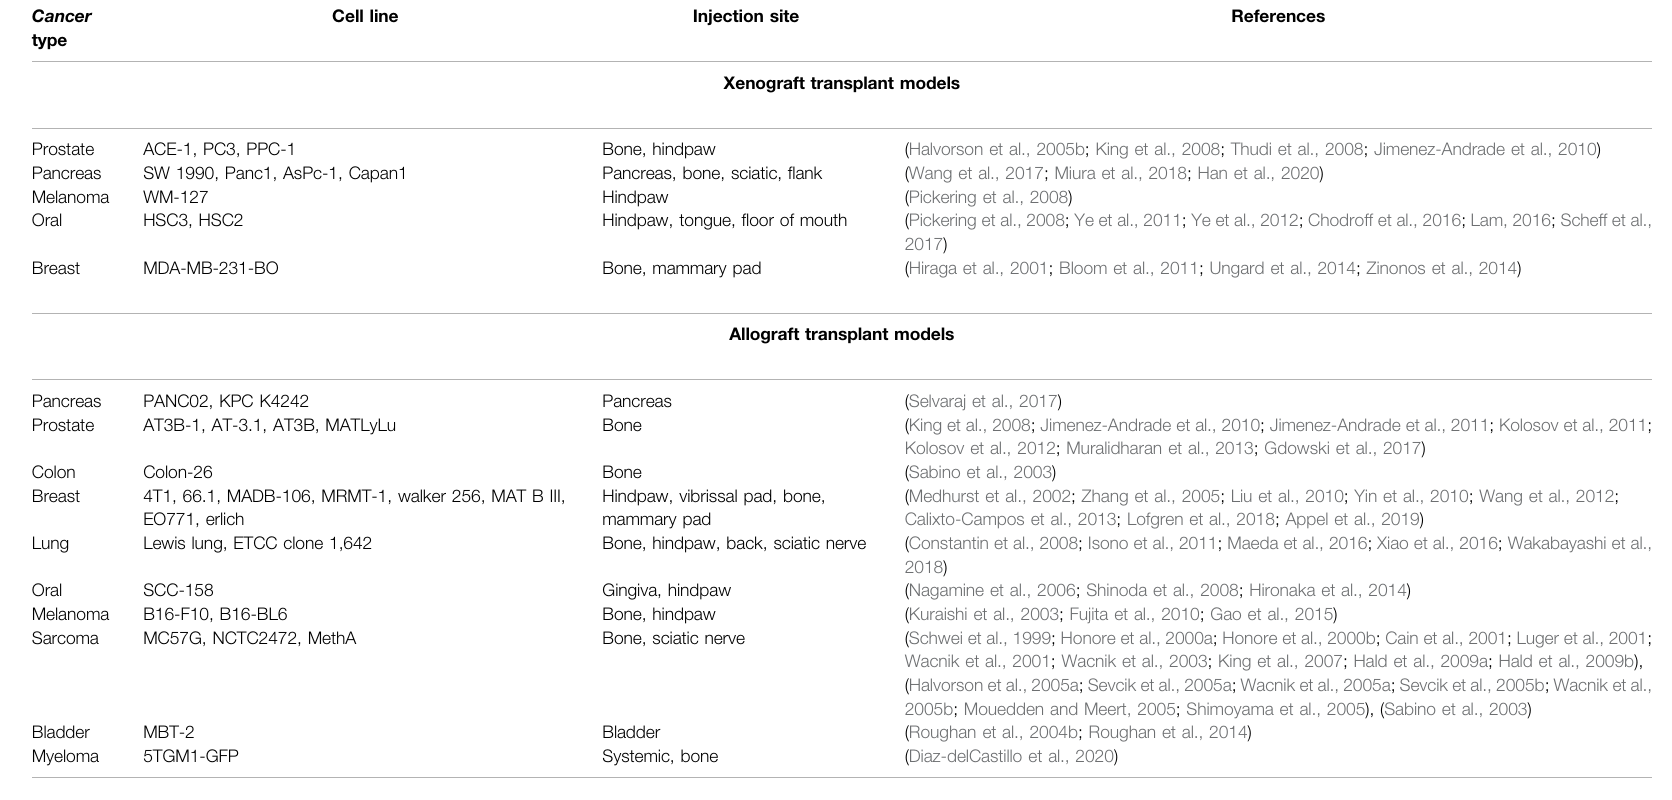
TABLE 1 | Transplantation cancer pain